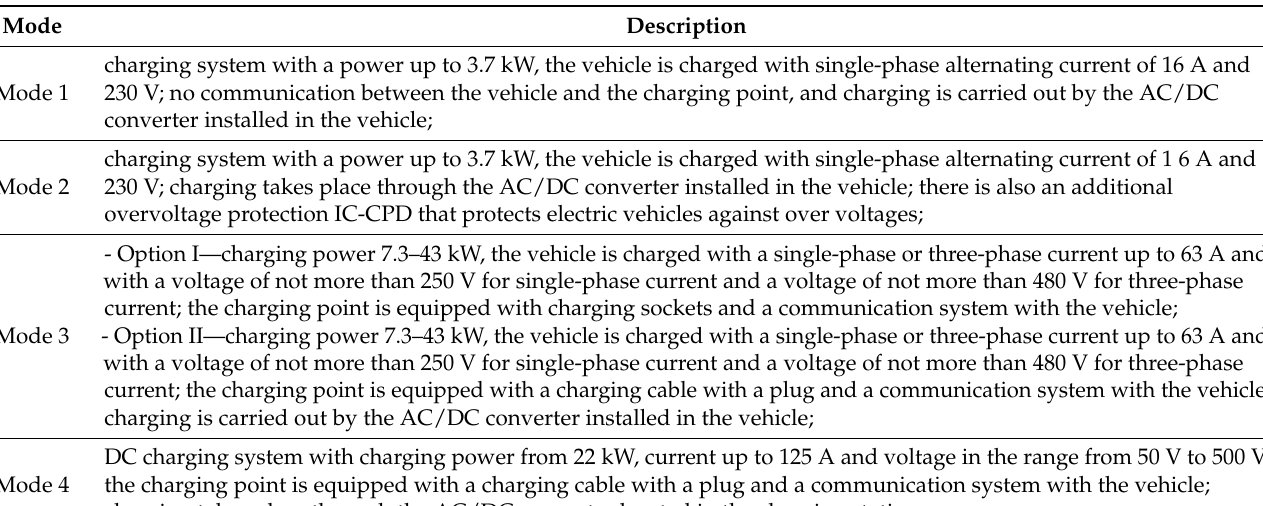
Table 1. Types of electric vehicles charging